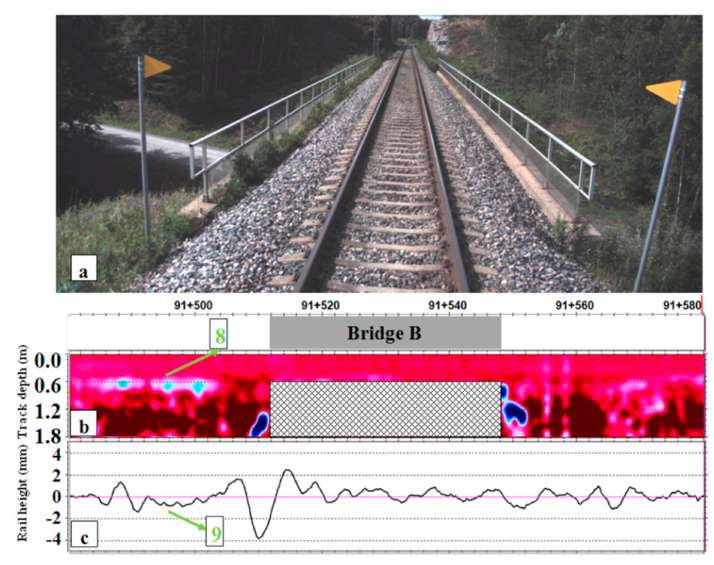
Figure 9. Measurement results of Transition Zone B: ( a ) photograph of the track; ( b ) the moisture profile; and, ( c ) the longitudinal track level.